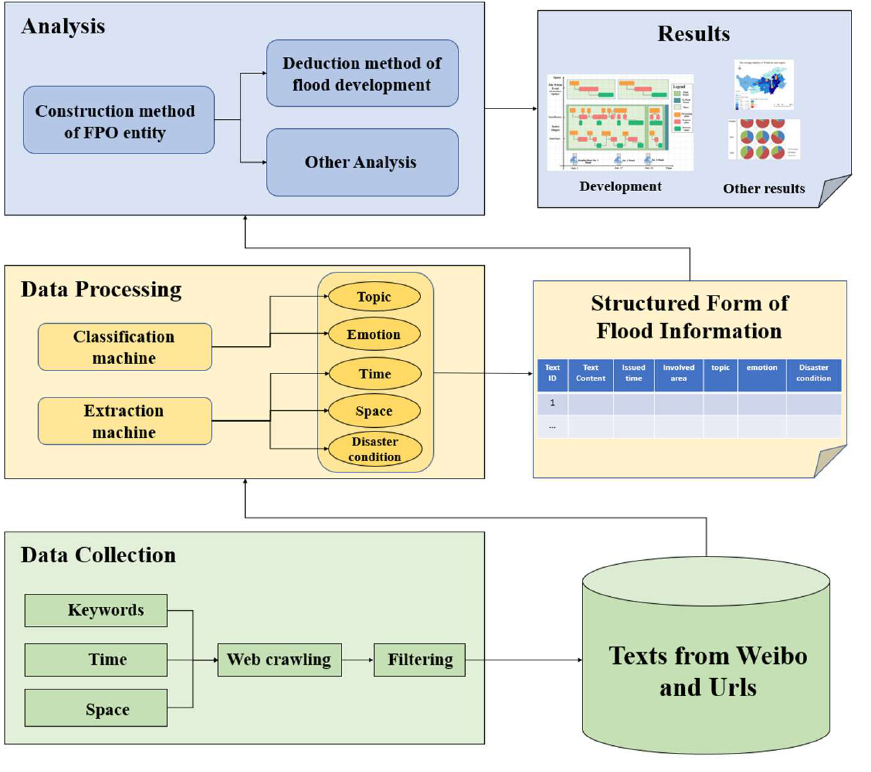
Figure 14. Experimental procedure of the case study.